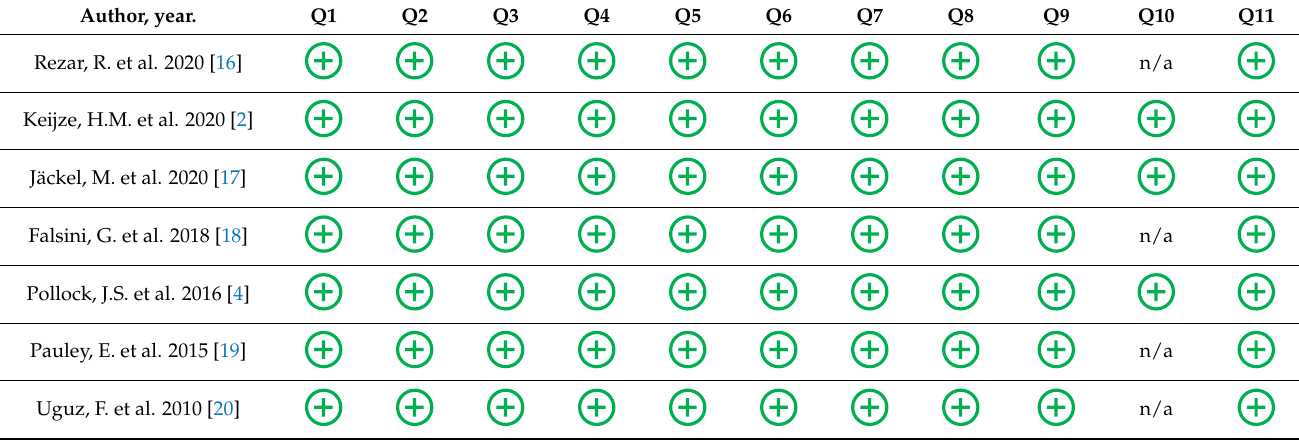
Figure 1. Table 3 presents a summary of the main results of the scoping